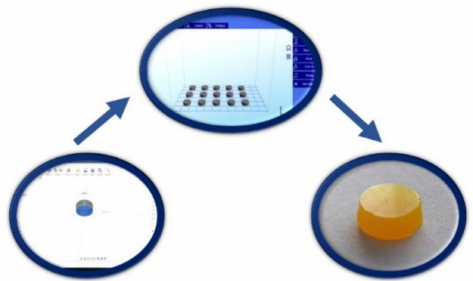
Figure 1. Digital light processing technology (DLP) printing process.